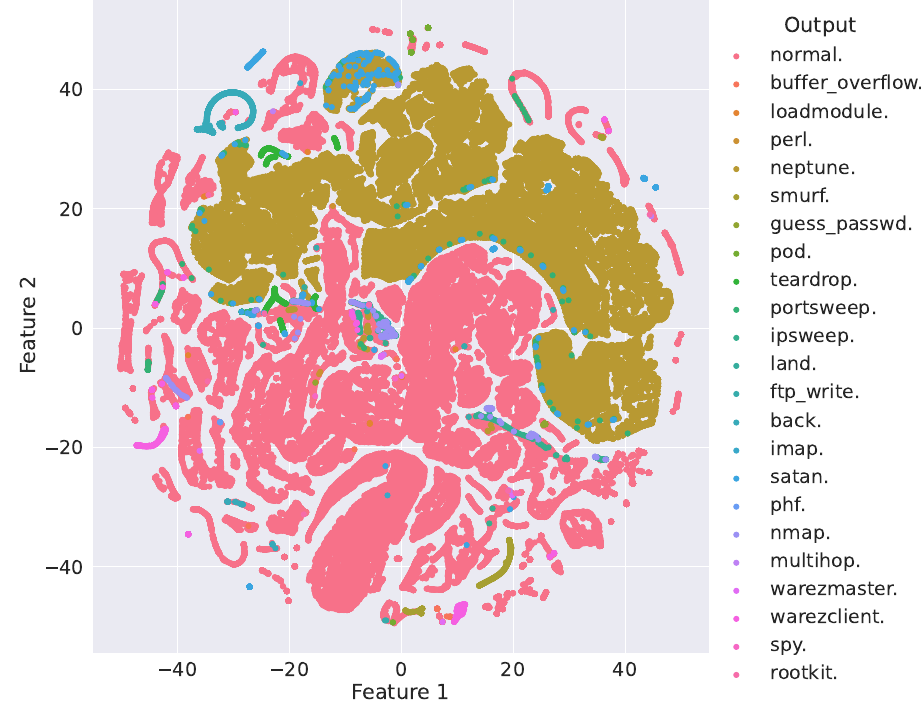
Figure 9. t-SNE plot with 50 perplexity and 1000 iteration